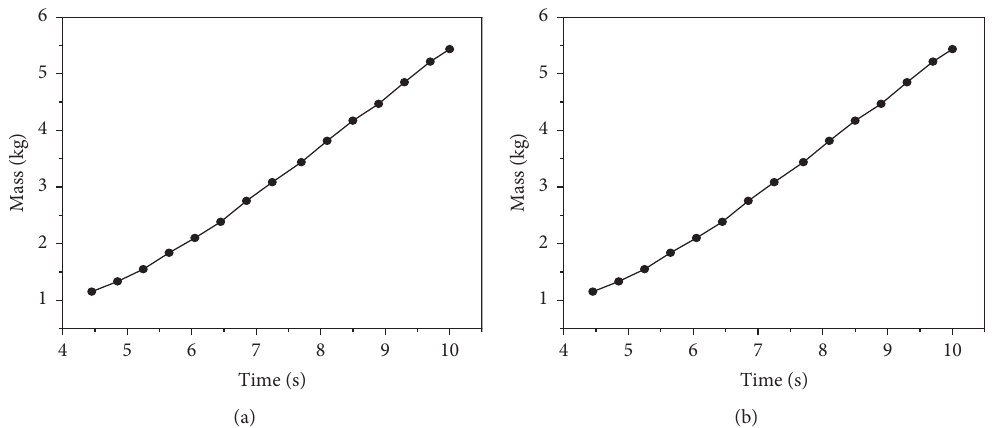
Figure 6: Comparison of simulation and physical experiments. (a) Simulation experiment. (b) Physical experiment.